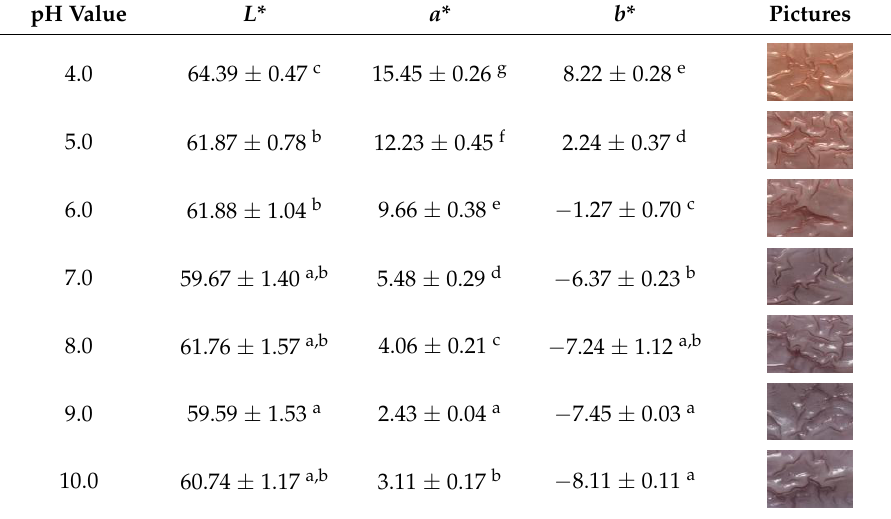
Table 2. Color parameters of the pH-sensing film in different buffer solutions at pH 4.0–10.0.